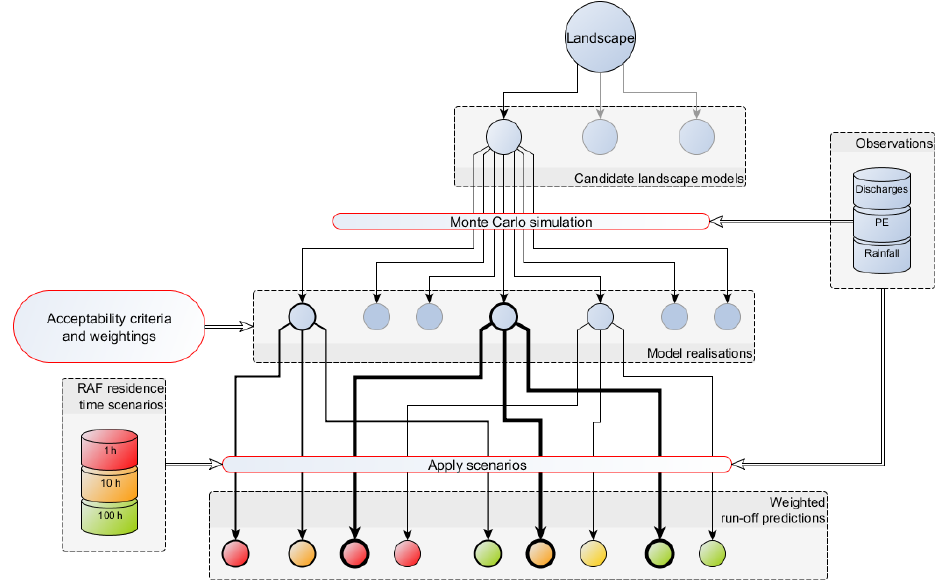
Figure 1. Work flow diagram for Monte Carlo simulation of storm run-off, and selection and weighting of behavioural realisations and application of NFM scenarios for forward prediction of change. The weight of lines leading from acceptable simulations reflects the weighting likelihood score in the validity of that realisation.